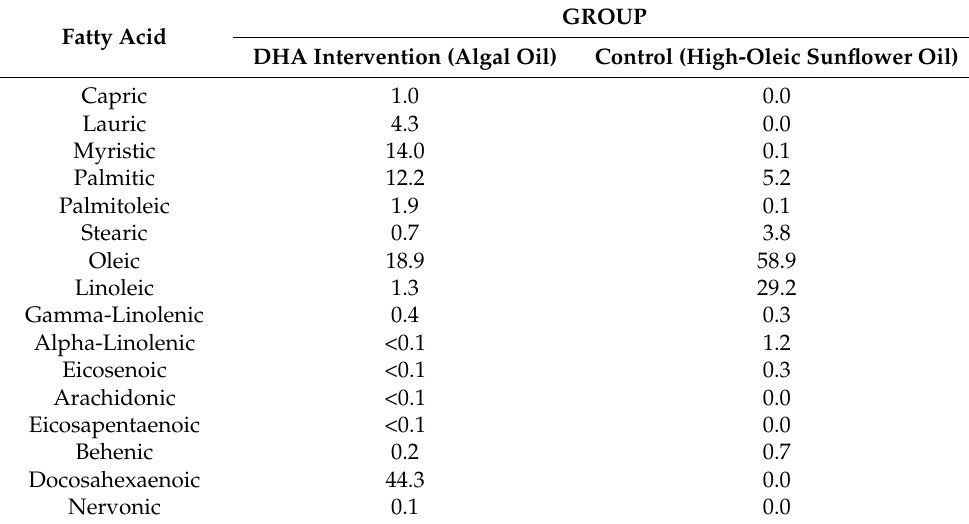
Table 1. Fatty acid composition of the intervention (docosahexaenoic acid (DHA)-rich) and sham oils (%wt of total fatty